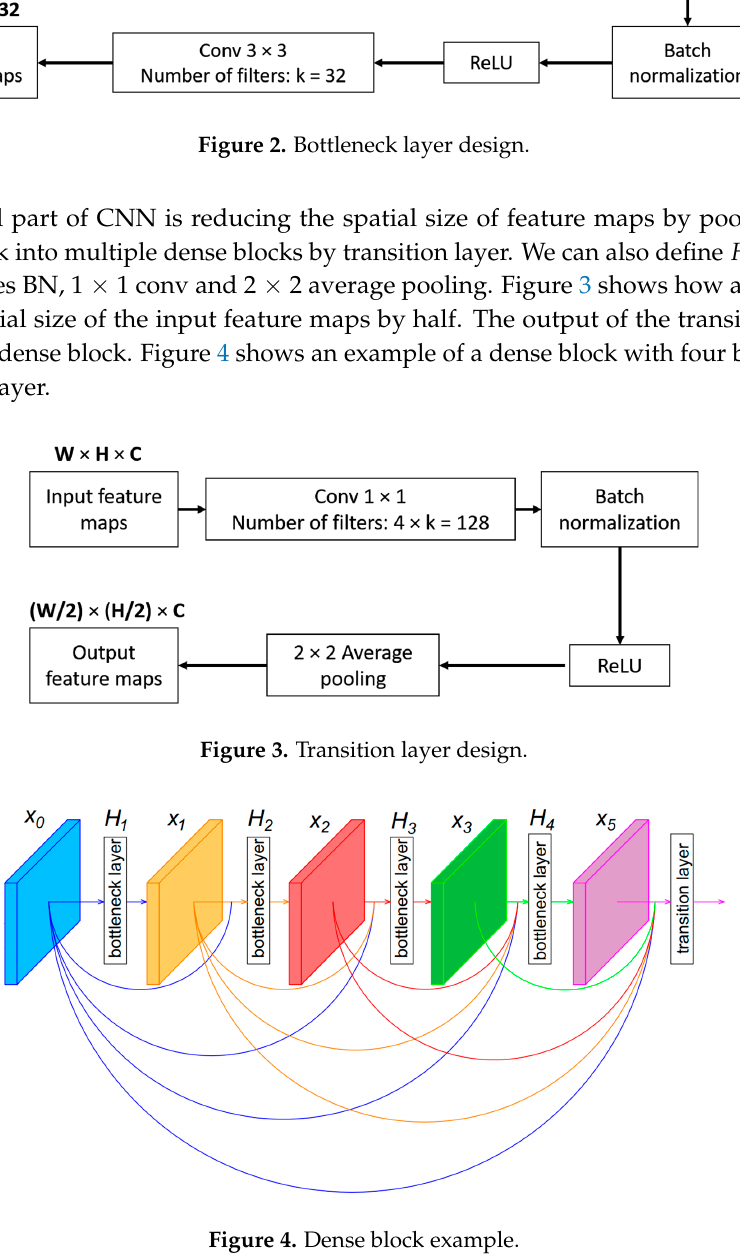
Figure 4. Dense block example.